Question: What kind of plot is shown here?
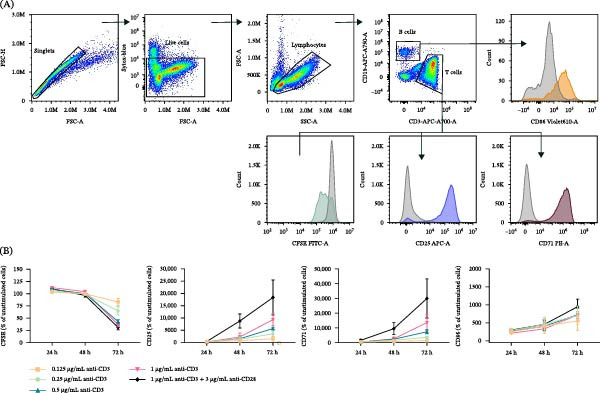
Answer: scatter